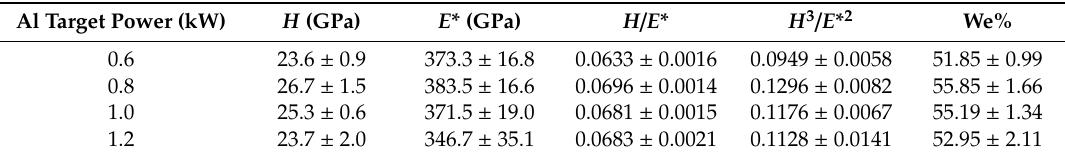
Table 2. Hardness ( H ), effective elastic modulus ( E *), H / E *, H 3 / E * 2 and elastic recovery (We) of the